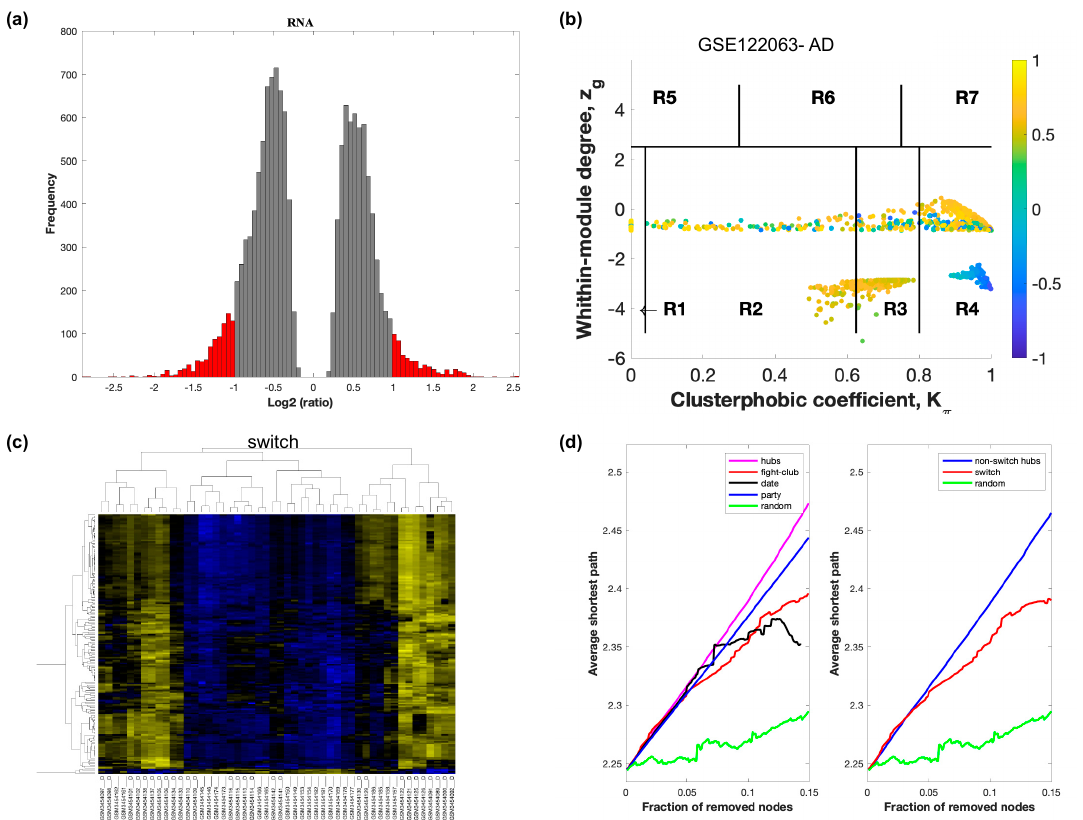
Figure 2. SWIM analysis of the frontal cortex of AD subjects in GSE122063. ( a ) Distribution of log2 fold change values where the red bars are selected for further analysis. ( b ) Heat Cartography Map with nodes colored by their average Pearson Correlation Coefficient. Region R4 represents the switch genes. ( c ) Dendrogram and heat map for switch genes. The suffix _D indicates the sample came from the diseased cohort. ( d ) Robustness of the correlation